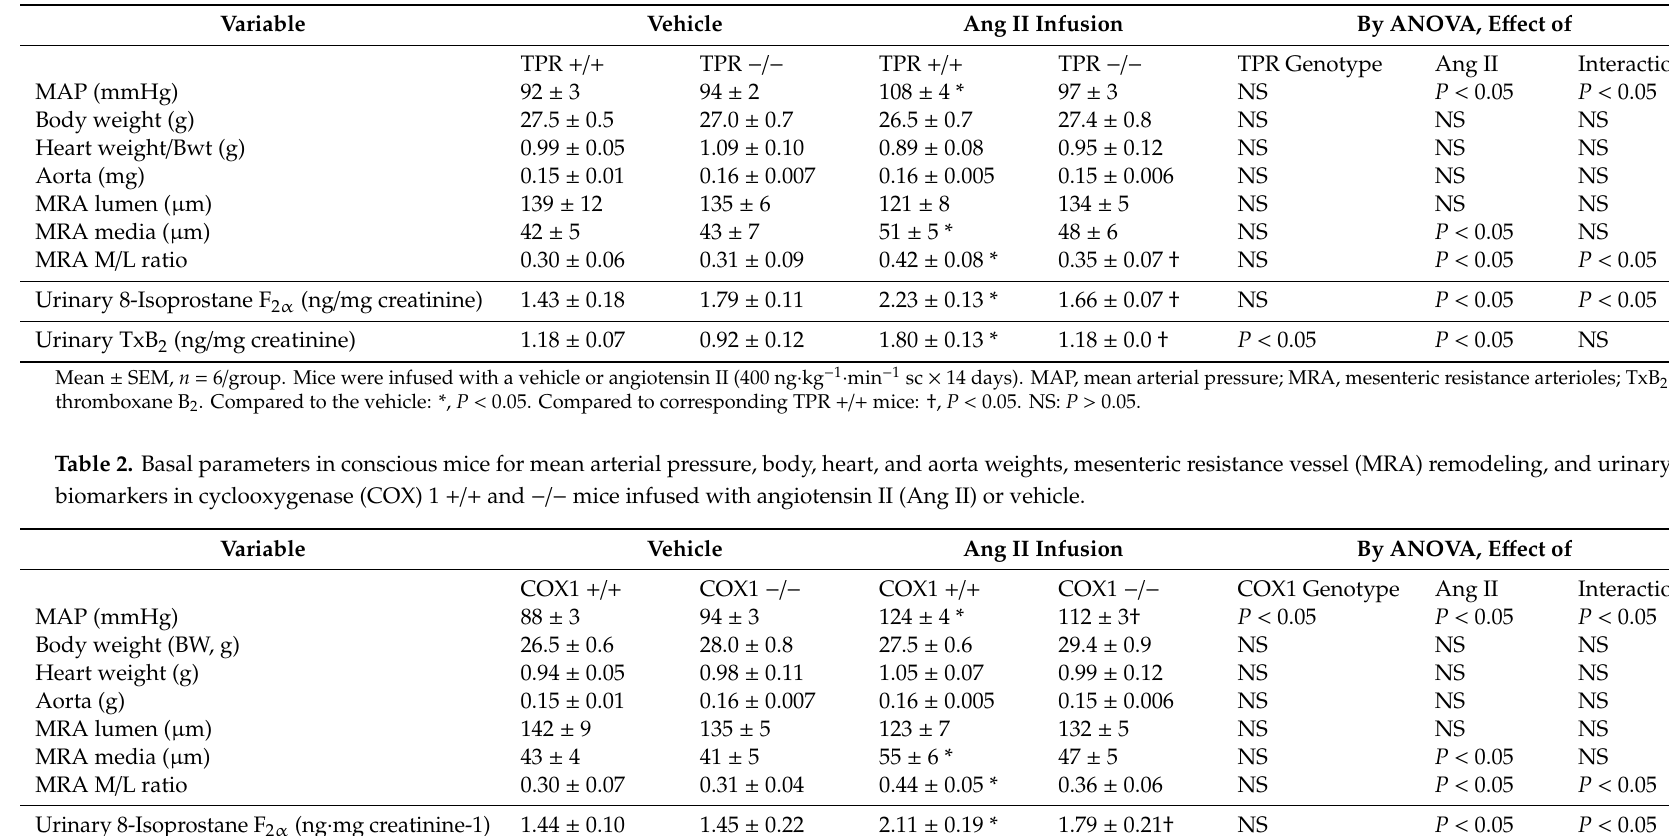
Table 1. Basal parameters in conscious mice for mean arterial pressure, body, heart, and aorta weight; mesenteric resistance arterioles (MRA) remodeling; and urinary biomarkers in thromboxane prostanoid receptor (TPR) +/+ and − / − mice infused with angiotensin II (Ang II) or vehicle.